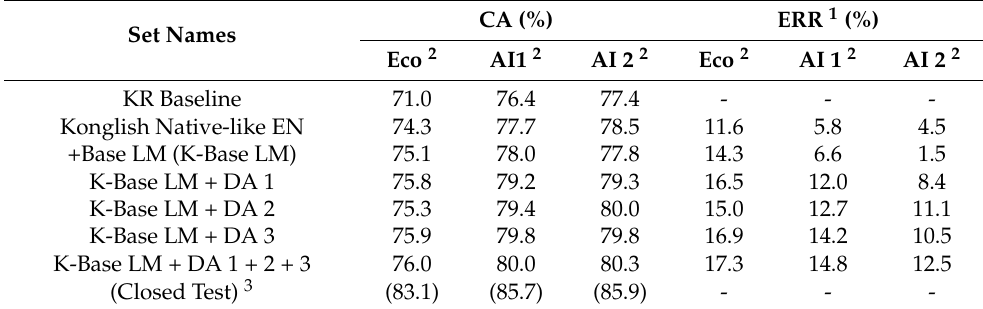
Table 6. Character accuracy (CA) of the domain adaptation.